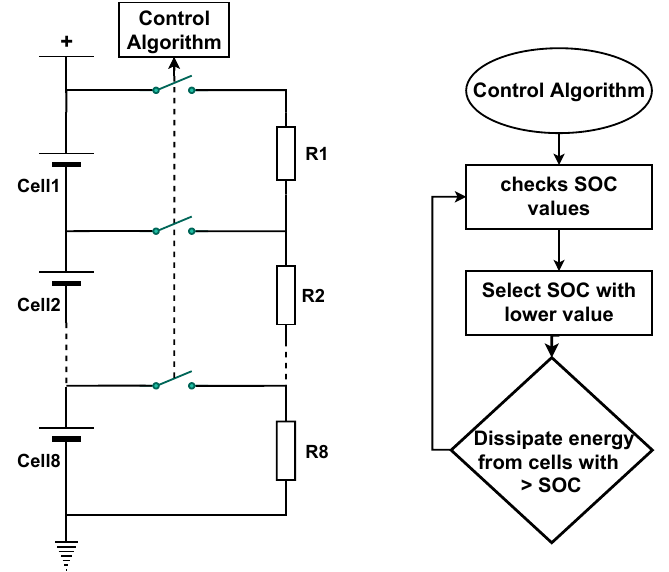
Figure 1. Schematic drawing of passive equalization.